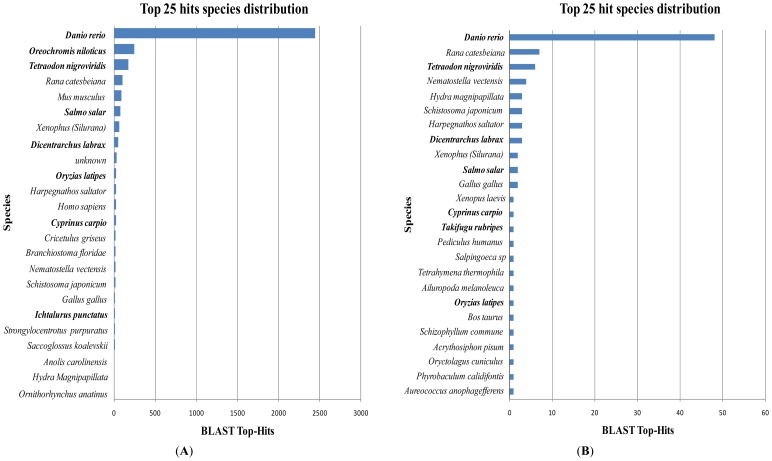
Top 25 hit species distribution based on BLASTx. E value cut-off is 10−5. Singleton (A) and contig (B). Bold text indicates teleosts.